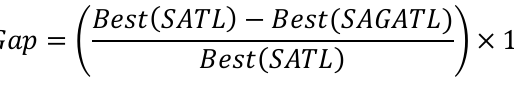
continuous casting 1 and (cid:1866) represents the number of sequences in continuous casting 2. Column 3 (cid:2870) represents the value of the objective function of the initial order proposed by the logistics service. The column 4 and 5: show the best results for each algorithm. For the column 6: shows the gap calculated using Eq. (1) between the SA-TL and SA-GA-TL. For all instances, the two algorithms obtain better solutions than the model mathematical. In Addition, the SA-GA-TL algorithm could obtain better solutions than the SA-TL.